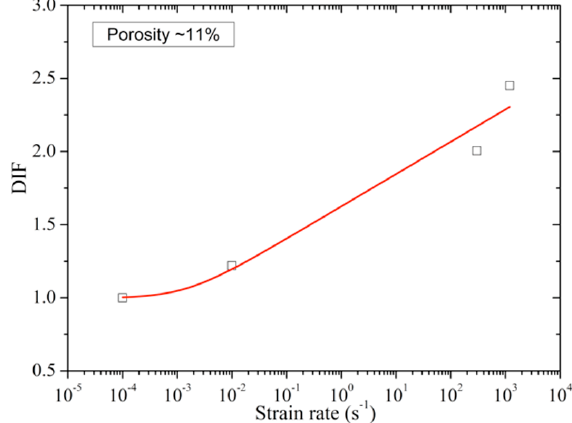
Figure 15. The dynamic increase factor as a function of strain rate.